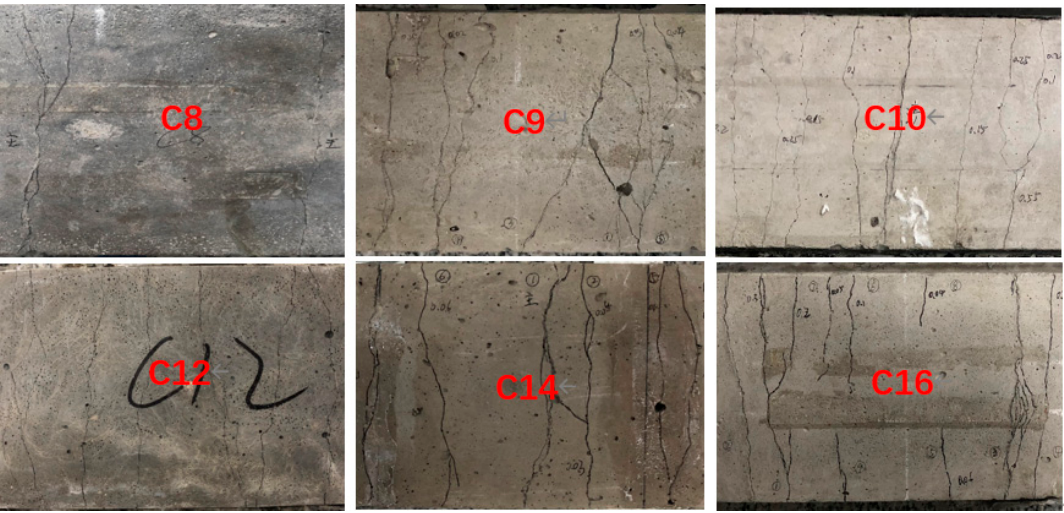
Figure 14. Typical cracking states of SSPP-ECC.